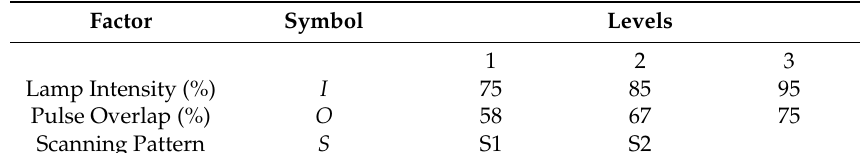
Table 2. Selected factors and their levels.